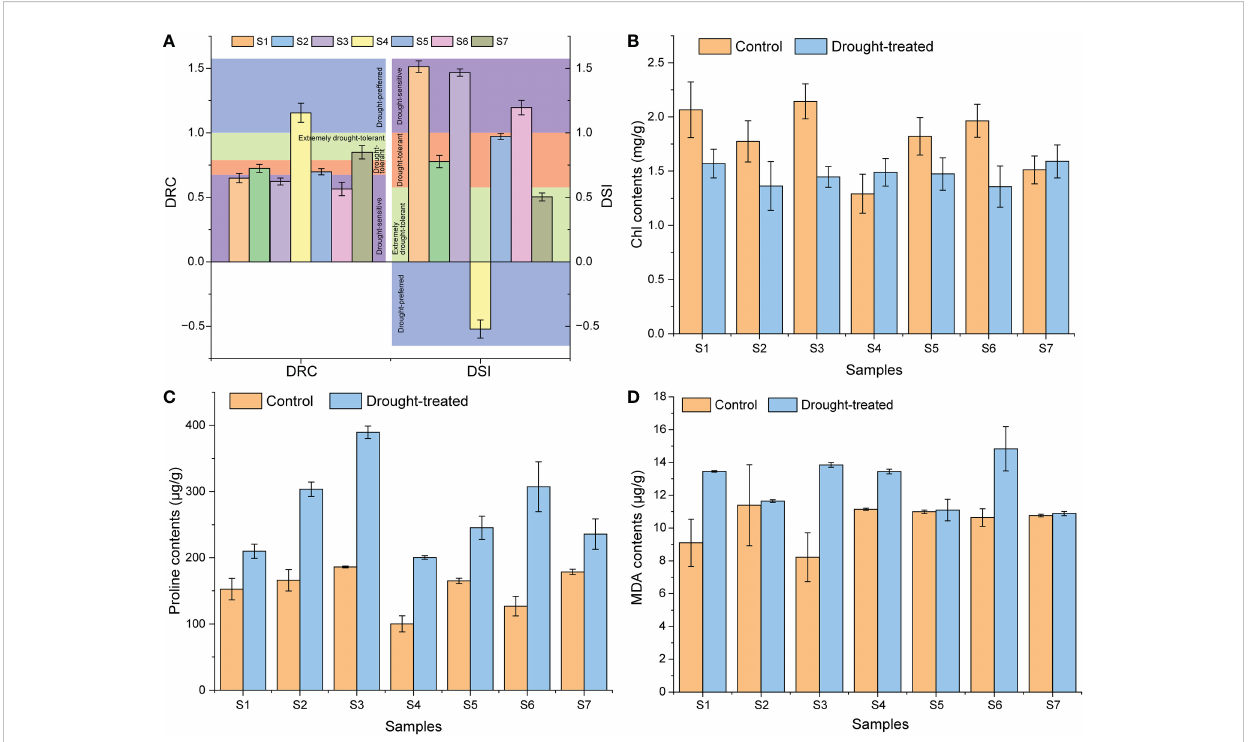
FIGURE 1 Physiological response of different sweet potato cultivars. (A) , the DRC and DSI values; (B) , the Chl contents. (C) , the proline contents. (D) , the MDA contents. S1, Control Shangshu-9; H1, Drought-treated Shangshu-9; S2, Control Chaoshu-1; H2, Drought-treated Chaoshu-1; S3, Control Xushu- 22; H3, Drought-treated Xushu-22; S4, Control Z15-1; H4, Drought-treated Z15-1; S5, Control Xushu-18; H5, Drought-treated Xushu-18; S6, Control Jishu-26; H6, Drought-treated Jishu-26; S7, Control Xuzi-8; H7, Drought-treated